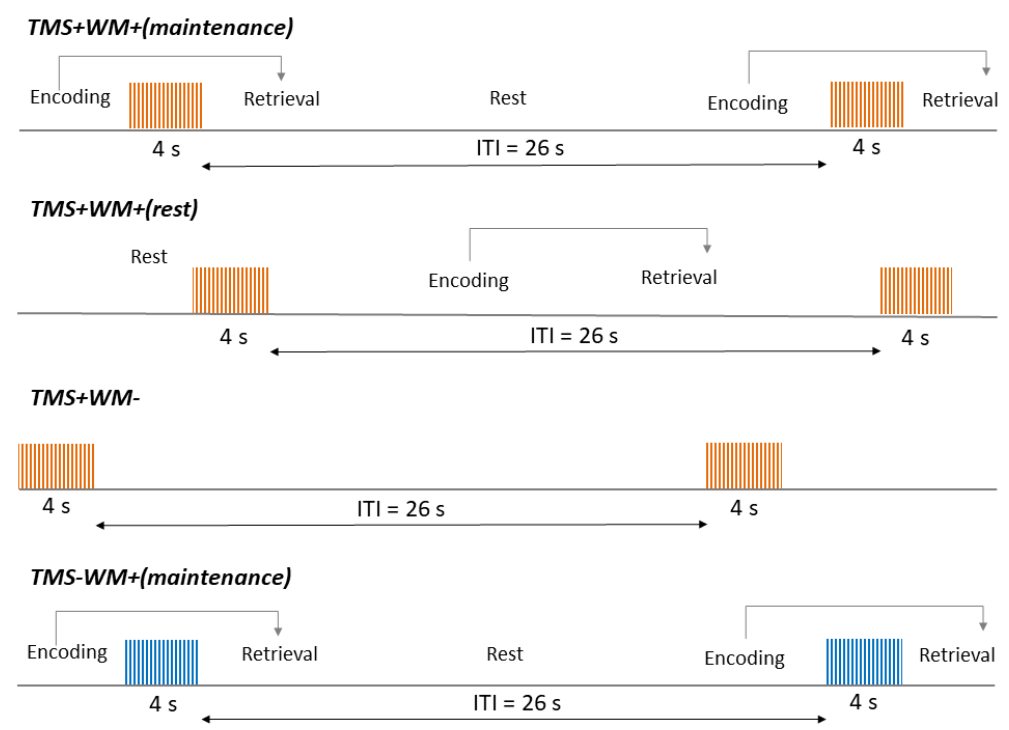
Figure 2. Illustration of high-frequency repetitive transcranial magnetic stimulation (HF rTMS) protocols used in the study. ITI, intertrain interval, TMS + WM + (maintenance), HF rTMS over the left DLPFC during maintenance period of the Sternberg task; TMS + WM + (rest), HF rTMS over the left DLPFC in the rest period between the presentations of the Sternberg task; TMS + WM − , HF rTMS over the left DLPFC without a cognitive load; TMS − WM + (maintenance), HF rTMS over the vertex during maintenance period of the Sternberg task.